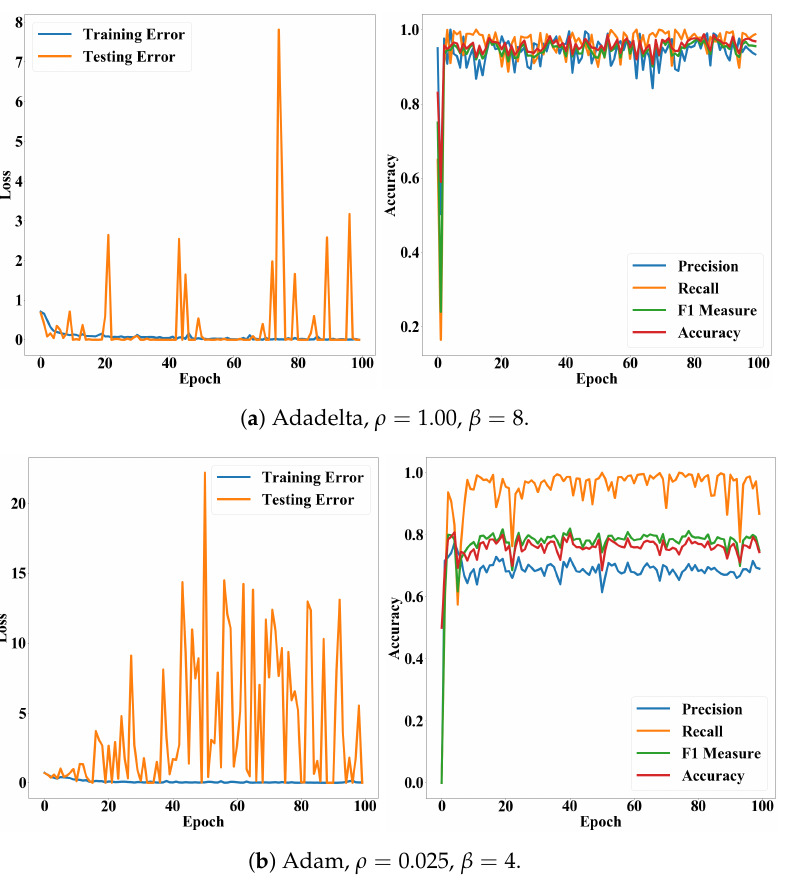
Figure 9. Loss and accuracy of the CNN model according to epochs. Subfigures ( a , b ) present accuracy and loss of the Adadelta and Adam on their optimal hyper-parameters, respectively. Table 2. The best performance of the proposed CNN model on each optimizer. Values in round brackets are standard deviations of the performance indicators for all validation cases. * and ** mark the first and second best performance,